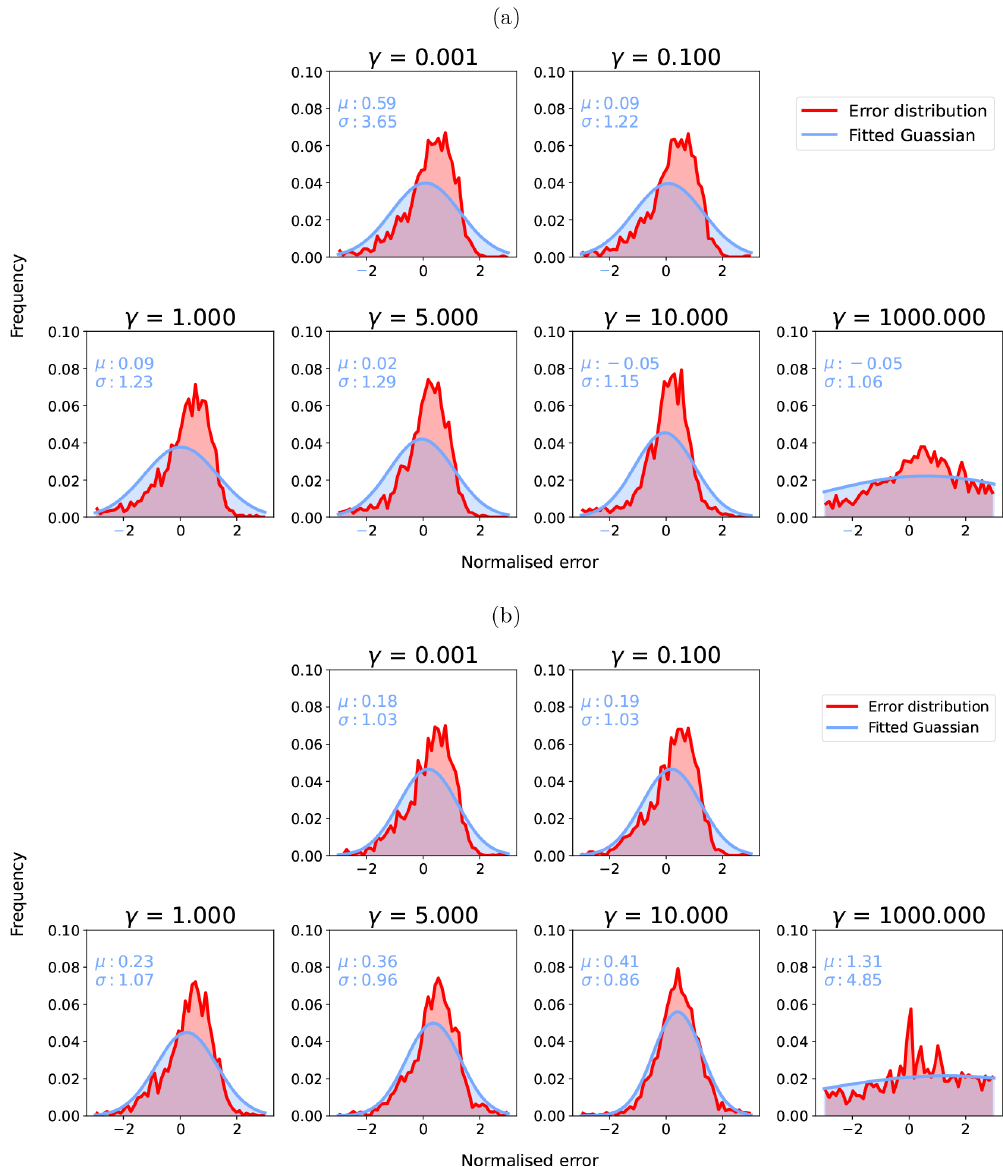
Figure 9. Standardised residual (cid:15) x distributions for S2 AOT (a) and L8 AOT (b) with γ of [0.001, 0.1, 1, 5, 10, 100, 1000]. The red atm histogram distributions show standardised error distributions (Error distribution) from the data and the blue ones the estimated Gaussian distribution from the distributions (Fitted